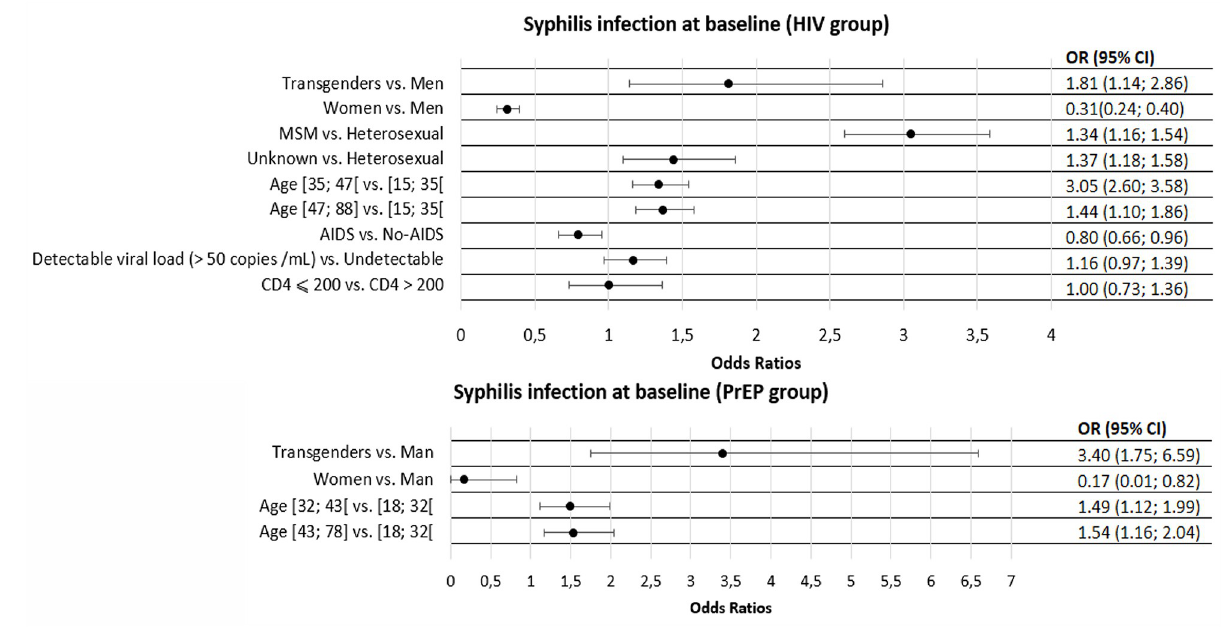
Fig 2. Adjusted odds ratios for factors associated with syphilis infection at baseline among